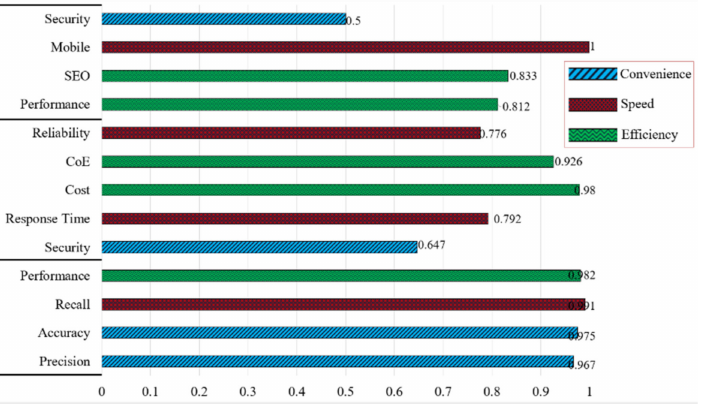
Figure 12. The clustered bar of AIoT shop evaluations. The range of each value locates between 0 and 1 from three aspects with 13 indicators of Society 5.0